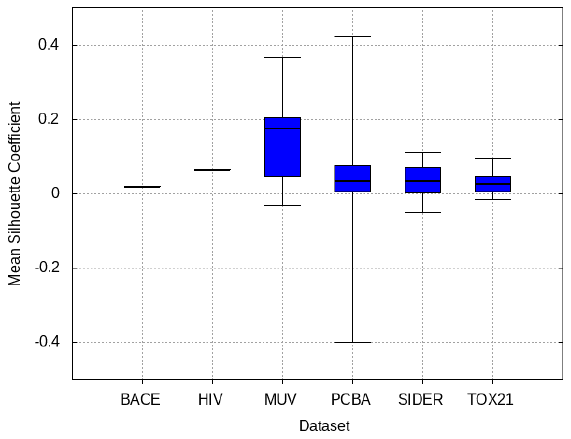
Figure 7. Mean Silhouette Coefficient (MSC) between each source dataset and target datasets. Higher MSC indicates more distinguishable clusters formed from bio-active and inactive molecules.